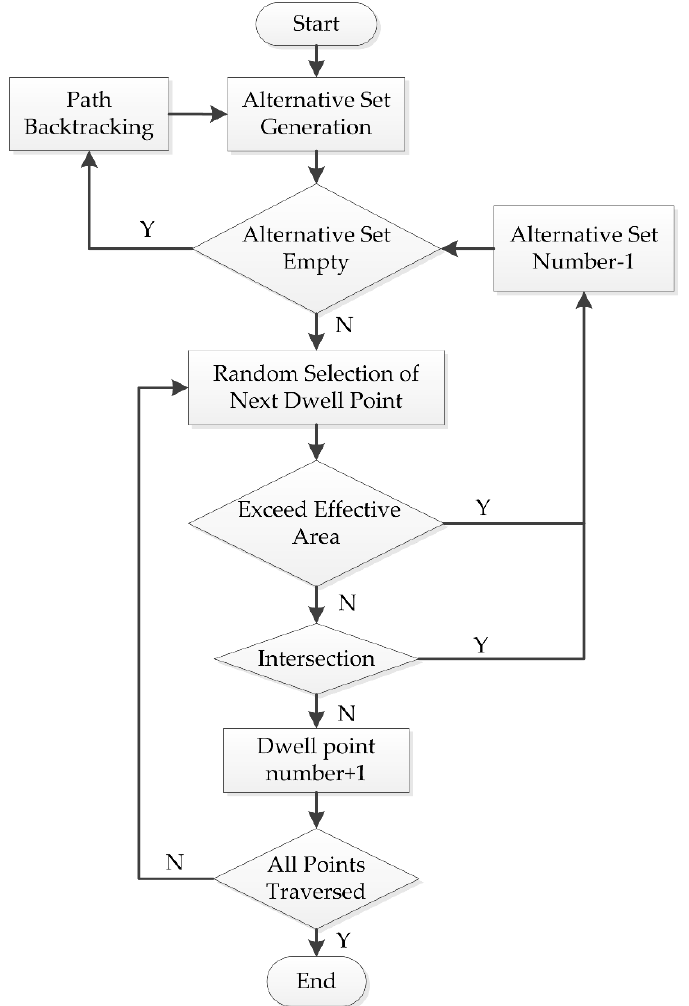
Figure 4. Flow chart of the changing path direction algorithm.